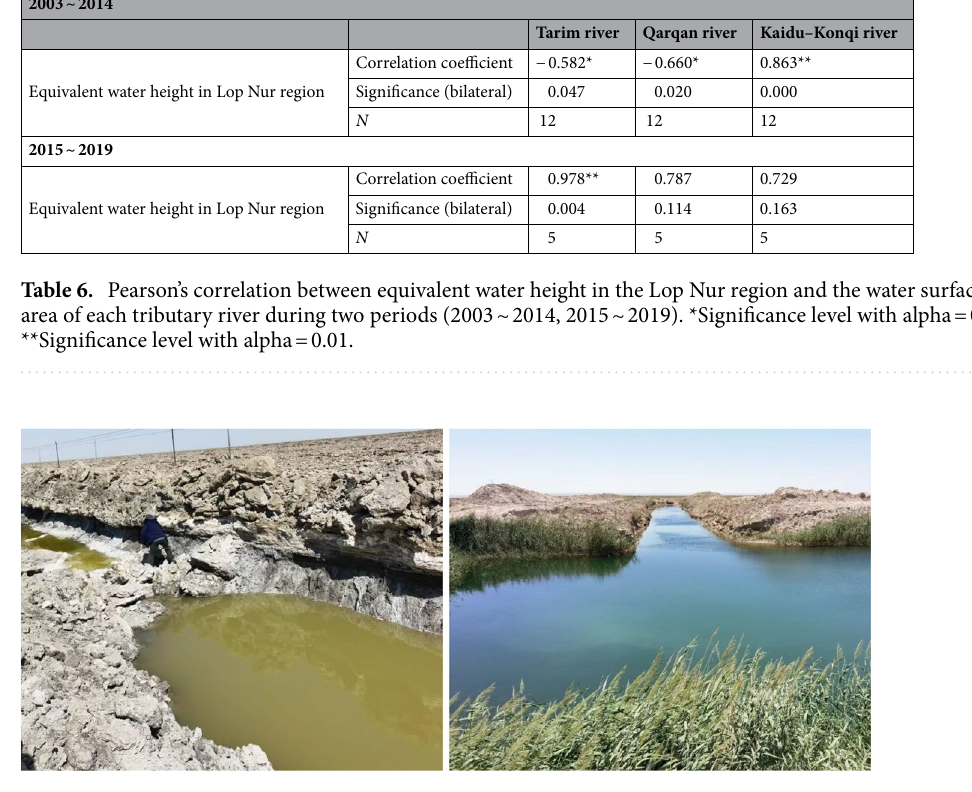
Figure 6. Burial depth of groundwater in central (Fig. 1, P1) and east (Fig. 1, P1) of Lop Nor region (The photo was taken by the corresponding author on July 27 & 28,